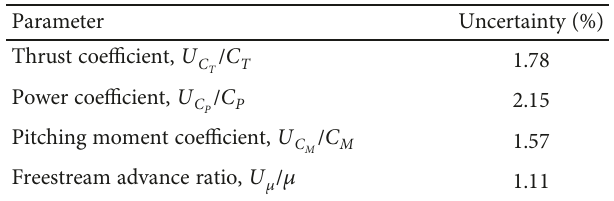
Table 2: Uncertainty percentages for the parameters of the rotor